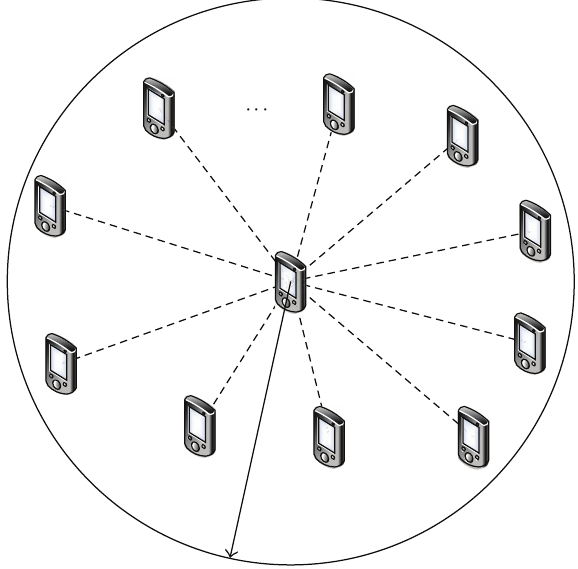
Figure 1: Experimental schematic of node